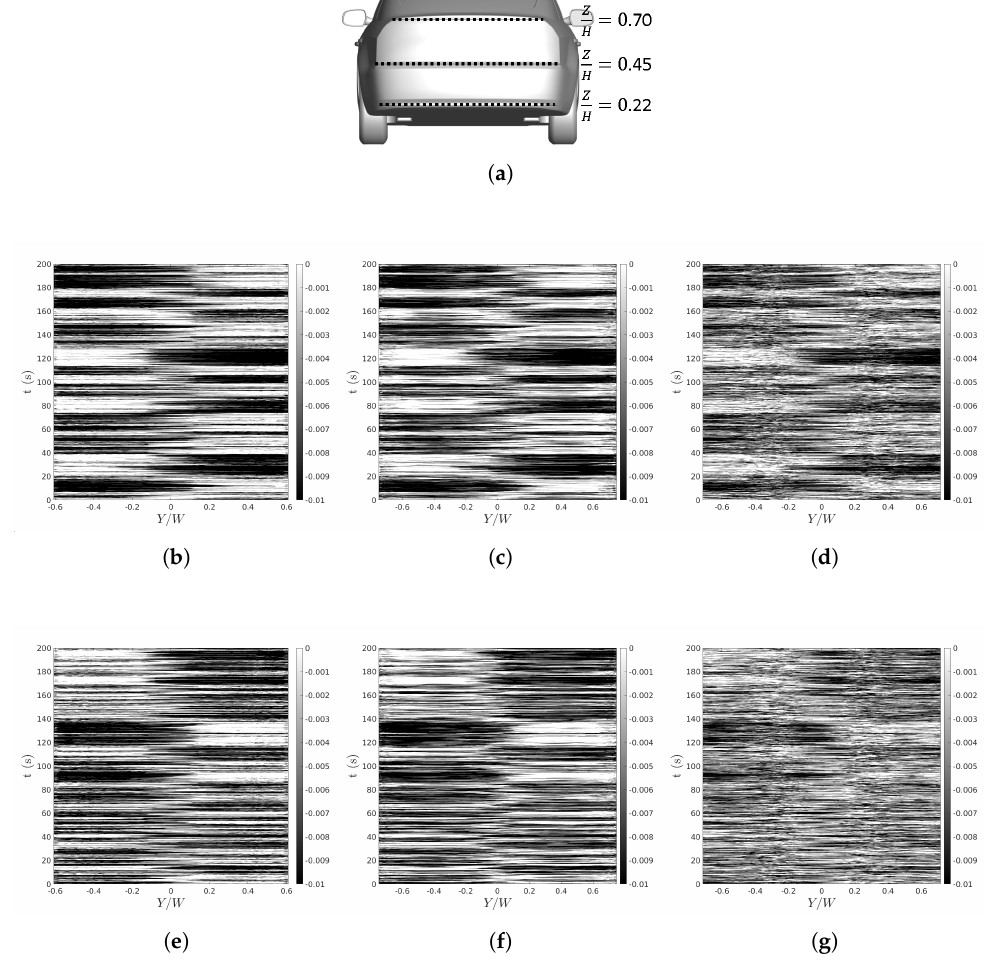
Figure 7. Fluctuations in the surface pressure coefficient C p extracted from ( a ) slices on the vehicle base at ( b ) Z / H = 0.70 (stationary wheels), ( c ) Z / H = 0.45 (stationary wheels), ( d ) Z / H = 0.22 (stationary wheels), ( e ) Z / H = 0.70 (rotating wheels), ( f ) Z / H = 0.45 (rotating wheels), and ( g ) Z / H = 0.2 (rotating